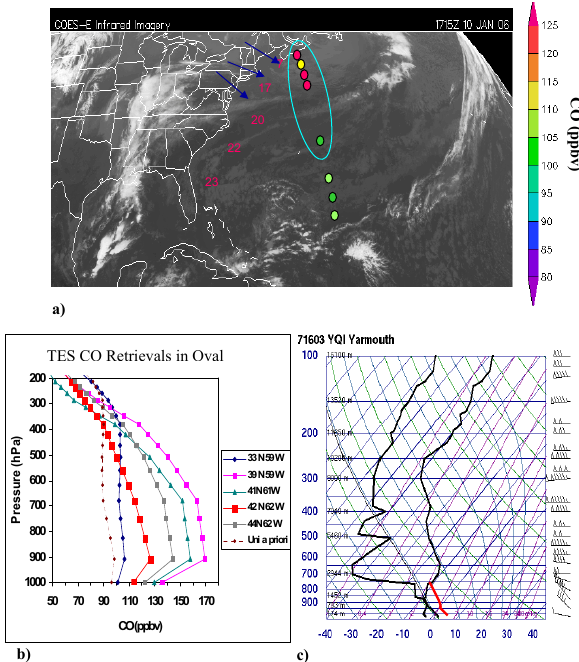
Fig. 6. Surface level CO export case on 10 January 2006, (a) GOES- East IR satellite image for 17:15UTC with TES 681hPa CO (ppbv) plotted in colored dots (b) TES CO retrieved profiles (in oval) and universal a priori profile (ppbv) for 17:00UTC and (c) Skew-T sounding plot from Yarmouth, Nova Scotia for 12:00UTC showing parcel ascent in red. The blue arrows on a) show the surface wind directions and sea surface temperatures from buoy measurements are plotted with red numbers.